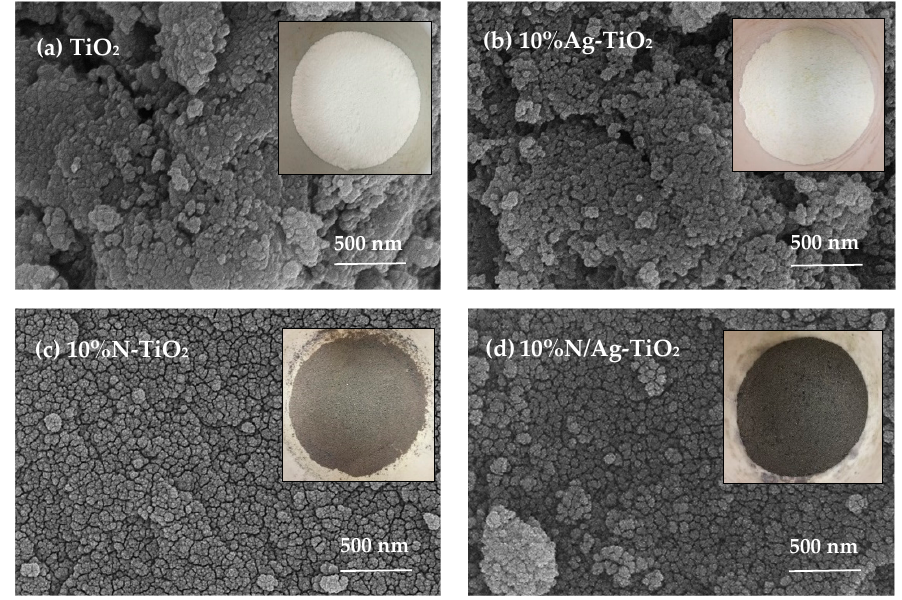
Figure 1. The surface morphology of ( a ) TiO 2 , ( b ) 10% Ag-TiO 2 , ( c ) 10% N-TiO 2 , and ( d ) 10% N/Ag-TiO 2 , determined from SEM.